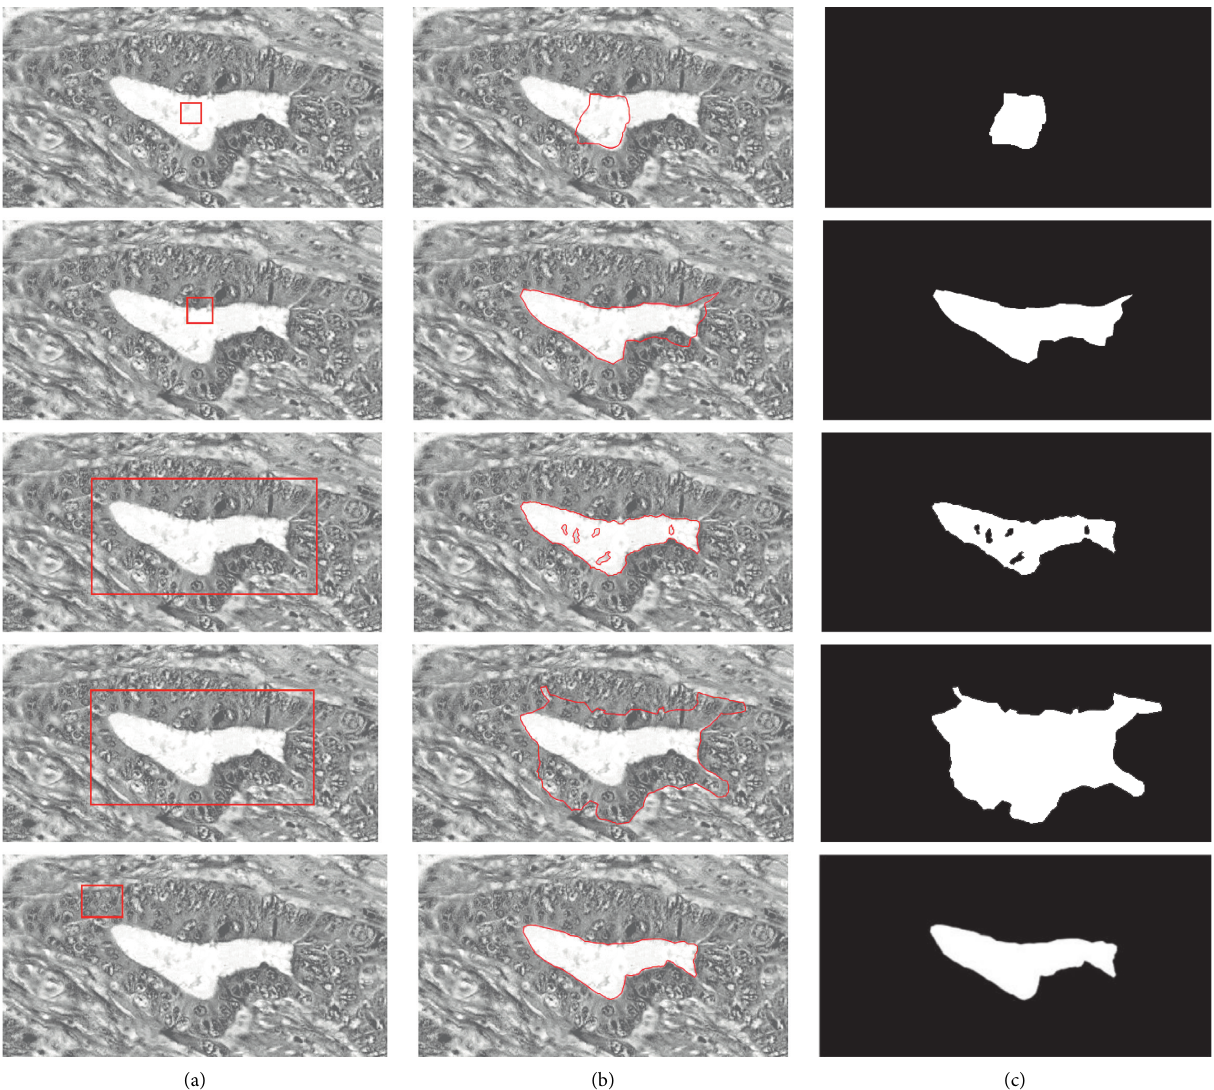
Figure 12: Segmentation of lumens using various contour models. The first row shows the results of the DRLSE model, the LBF model results are shown in the second row, the third row shows the results of the LGDF model, the fourth row shows the results of the LIF model, and the results of the proposed method are shown in the fifth row. Column (a) shows the position of the initial contour. Column (b) shows the output obtained after several iterations. Column (c) shows the results of gland cavity